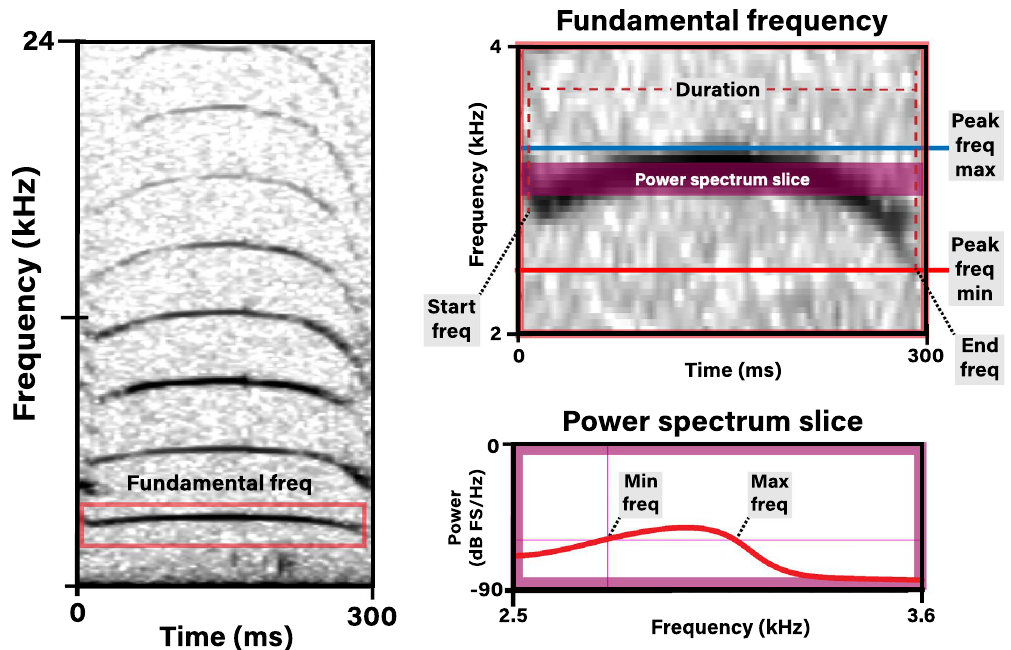
Figure 1. Schematics showing how the acoustic parameters of the vocalizations of manatee calves were extracted. The spectrogram on the left shows a single manatee call with the fundamental frequency of the call boxed in. The same box is expanded in the top right to show how duration (ms), frequency modulation (kHz) (peak frequency maximum minus peak frequency minimum), start frequency, and end frequency (kHz) were measured. The shaded area overlapping the call illustrates the power spectrum slice expanded in the bottom right showing the measurement of the power at the minimum and maximum frequencies (kHz) of the selected call. All measurements were conducted in Raven 1.6 39 . Spectrogram parameters: DFT: 512 point; Hamming window; 50%